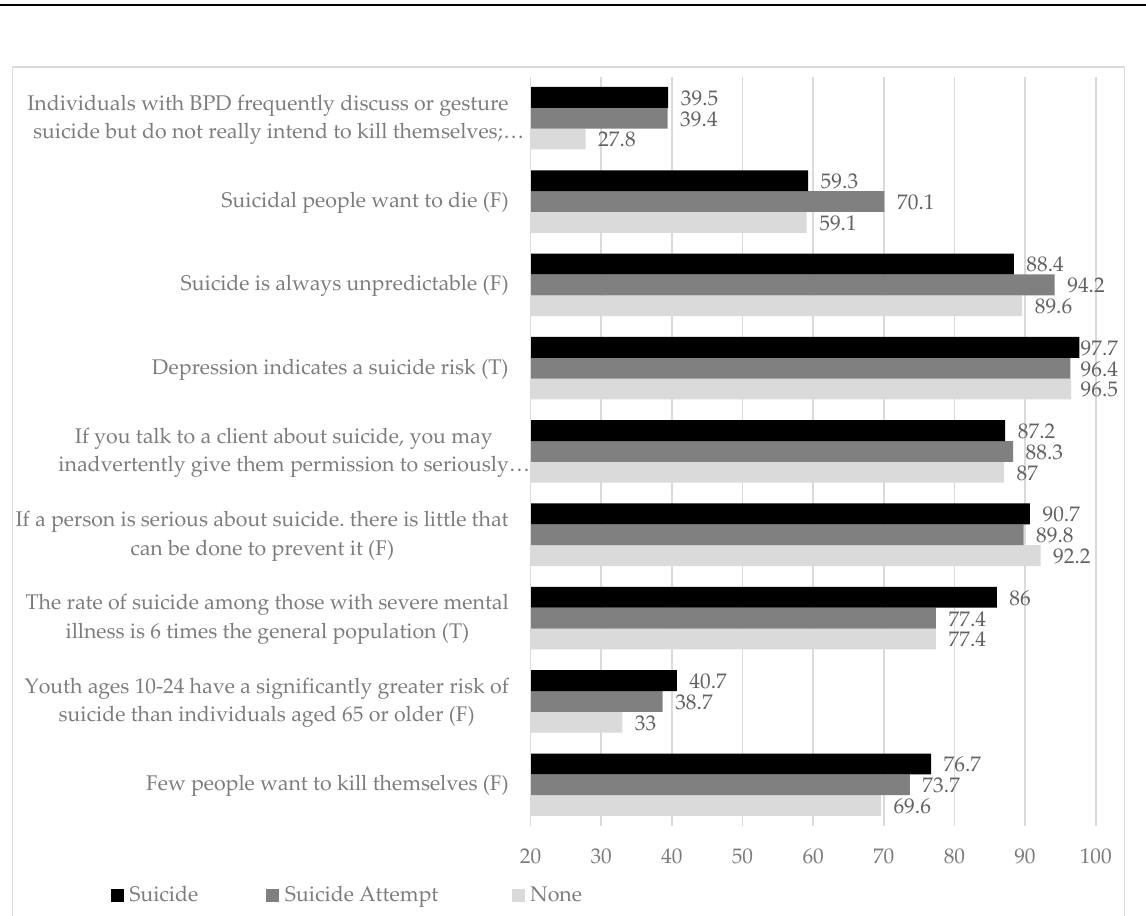
Figure 2. Differences between subgroups according to the experience of patient’s suicide.